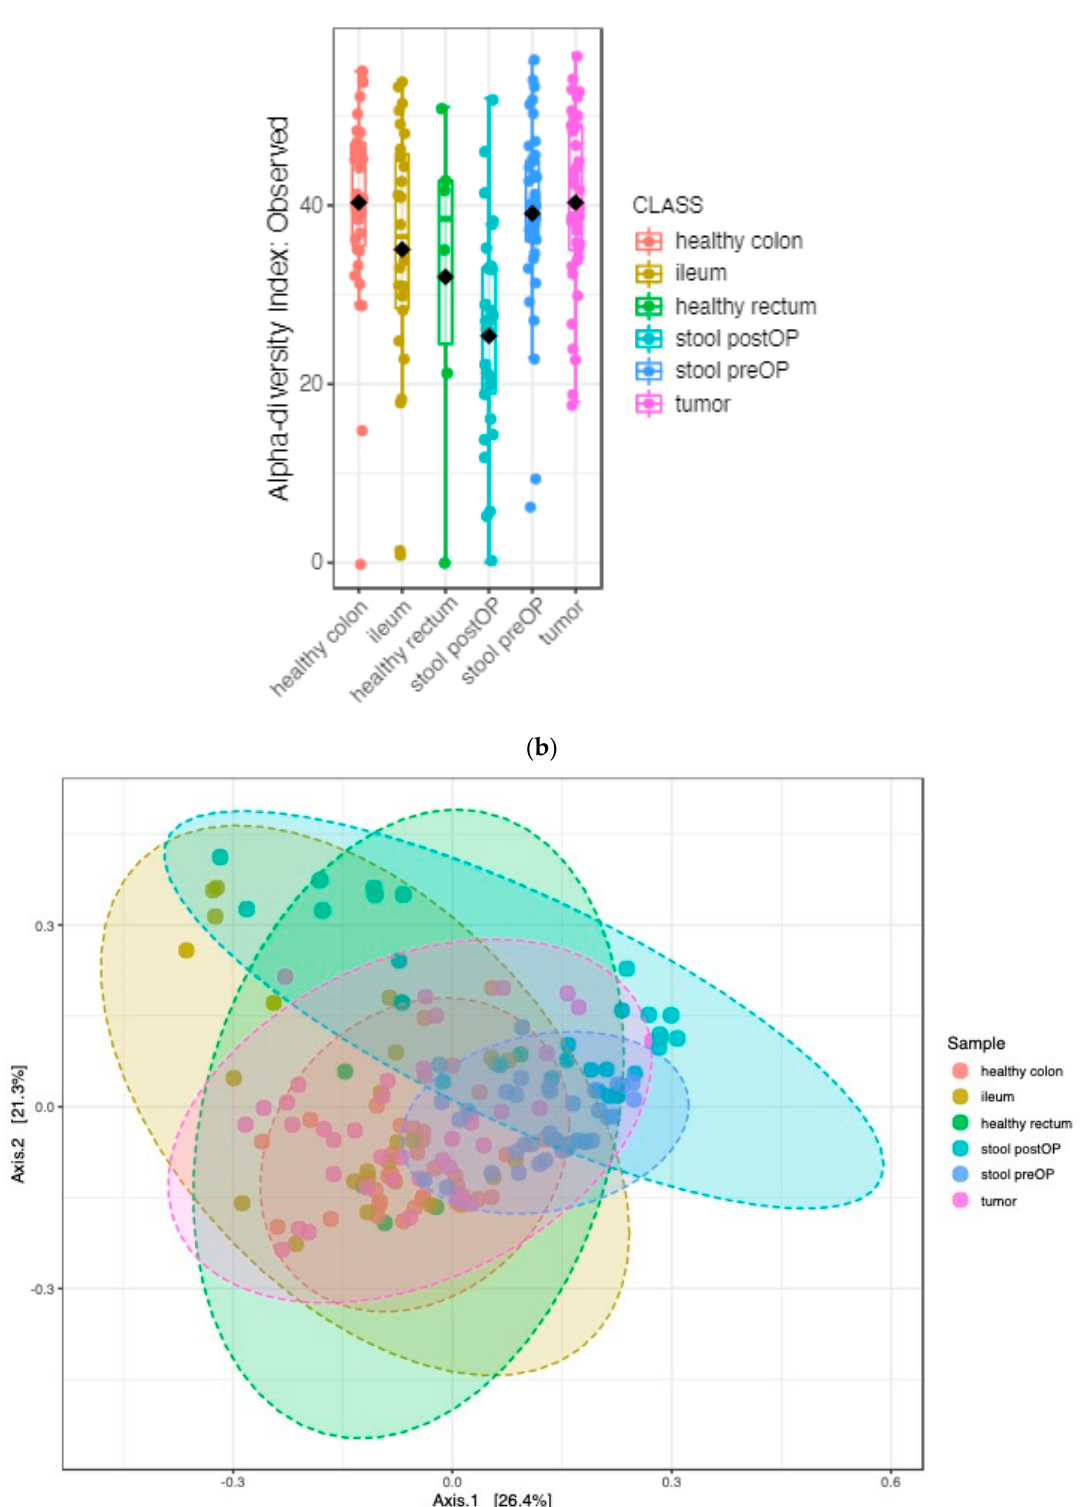
Figure 2. Microbiome diversity comparison between the locations of CC patients: alpha diversity box plot (Observed, p value < 0.001) ( a ) and principal coordinate analysis (PCoA) using Jensen–Shannon metric distances of beta diversity ( b ) at the genus level, p value < 0.001.